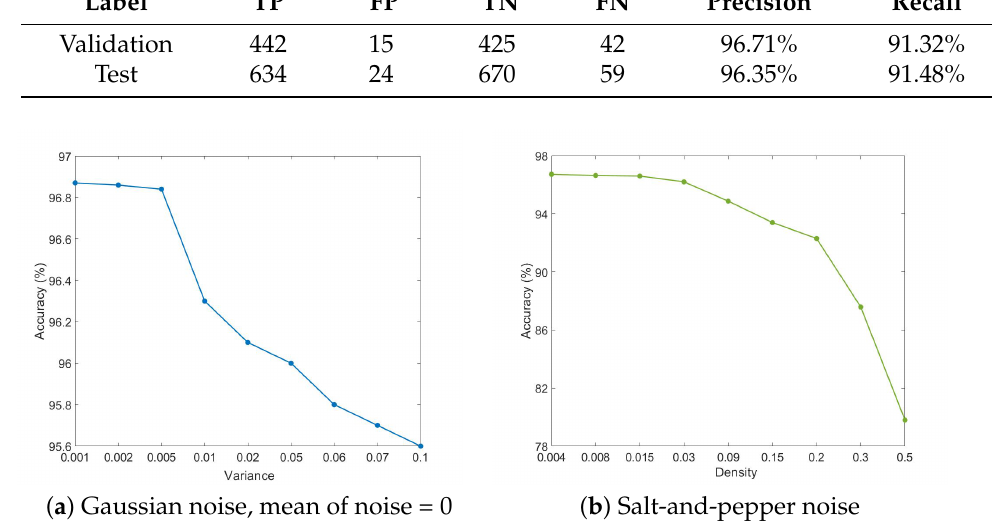
Figure 14. 3D-CNN accuracy variation in the noise-added test